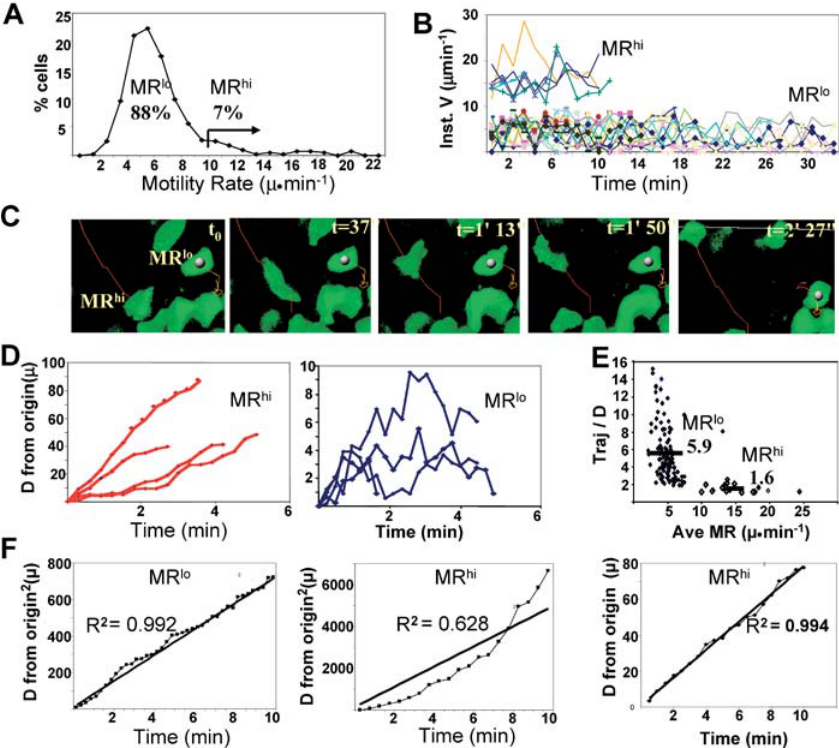
Figure 2. Two Distinct Migratory Behaviors within Wild-Type Cortical Thymocytes (A) Histogram showing the frequency distribution of average motility rates (MR) for cortical thymocytes compiled from over 1,250 tracked cells from four independently imaged thymic lobes. The vast majority of cells exhibited speeds ranging from 3 to 8 l m/min (MR lo ). Approximately 7% exhibited speeds of 10 l m/min or greater (MR hi ). Cells migrating between 10–13 l m/min represented approximately 5% of cortical thymocytes, and those with speeds of 14 l m/min or greater represented approximately 2% of cortical thymocytes. (B) Instantaneous velocities versus time for representative MR hi and MR lo cells. Data are representative of 53 MR hi cells and more than 200 MR lo cells analyzed. No conversions between MR hi or MR lo behaviors were observed over a combined imaging time of more than 30 h. (C) Five successive time frames showing the morphology associated with propulsion for an MR hi and an MR lo cell (Video S5). (D) Graph of displacement versus time for four individual MR hi and MR lo cells. (E) Graph of directional index (Traj/D) versus average motility rate. The bars indicate the average values for Traj/D computed from 50 MR hi and 466 MR lo cells . (F) Graph of MR lo cells (left), but not MR hi cells (middle), shows linear relationship between the square of the displacement from origin versus time, indicative of random walk. Right graph shows a linear relationship between displacements from origin (as opposed to their square) with increasing time for MR hi cells, indicative of ballistic motion (right). Analysis was done on 466 MR lo cells and 50 MR hi cells from three independently imaged thymic